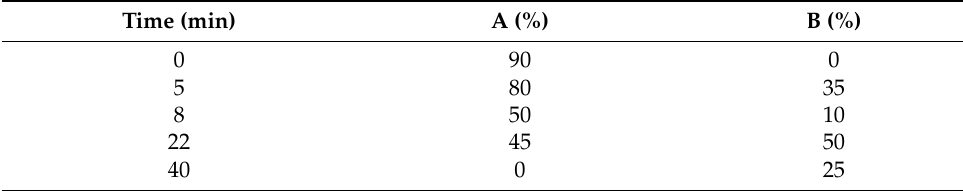
Table 3. The gradient elution of